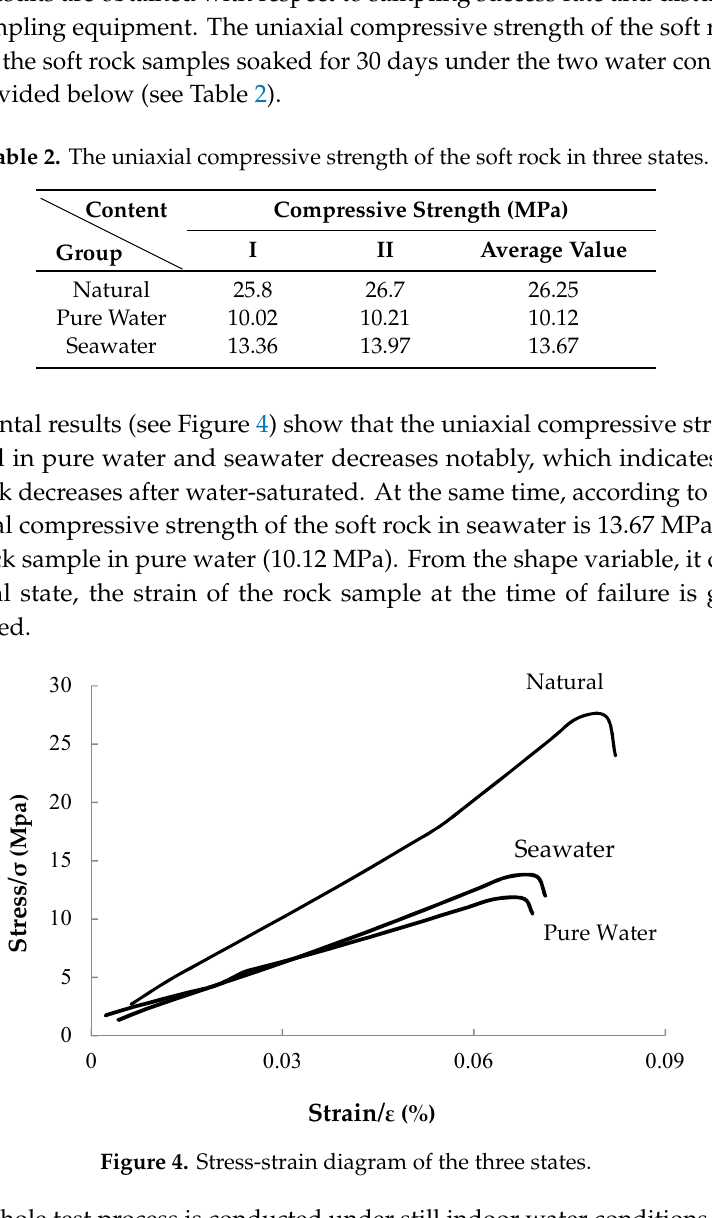
Table 2. The uniaxial compressive strength of the soft rock in three states.